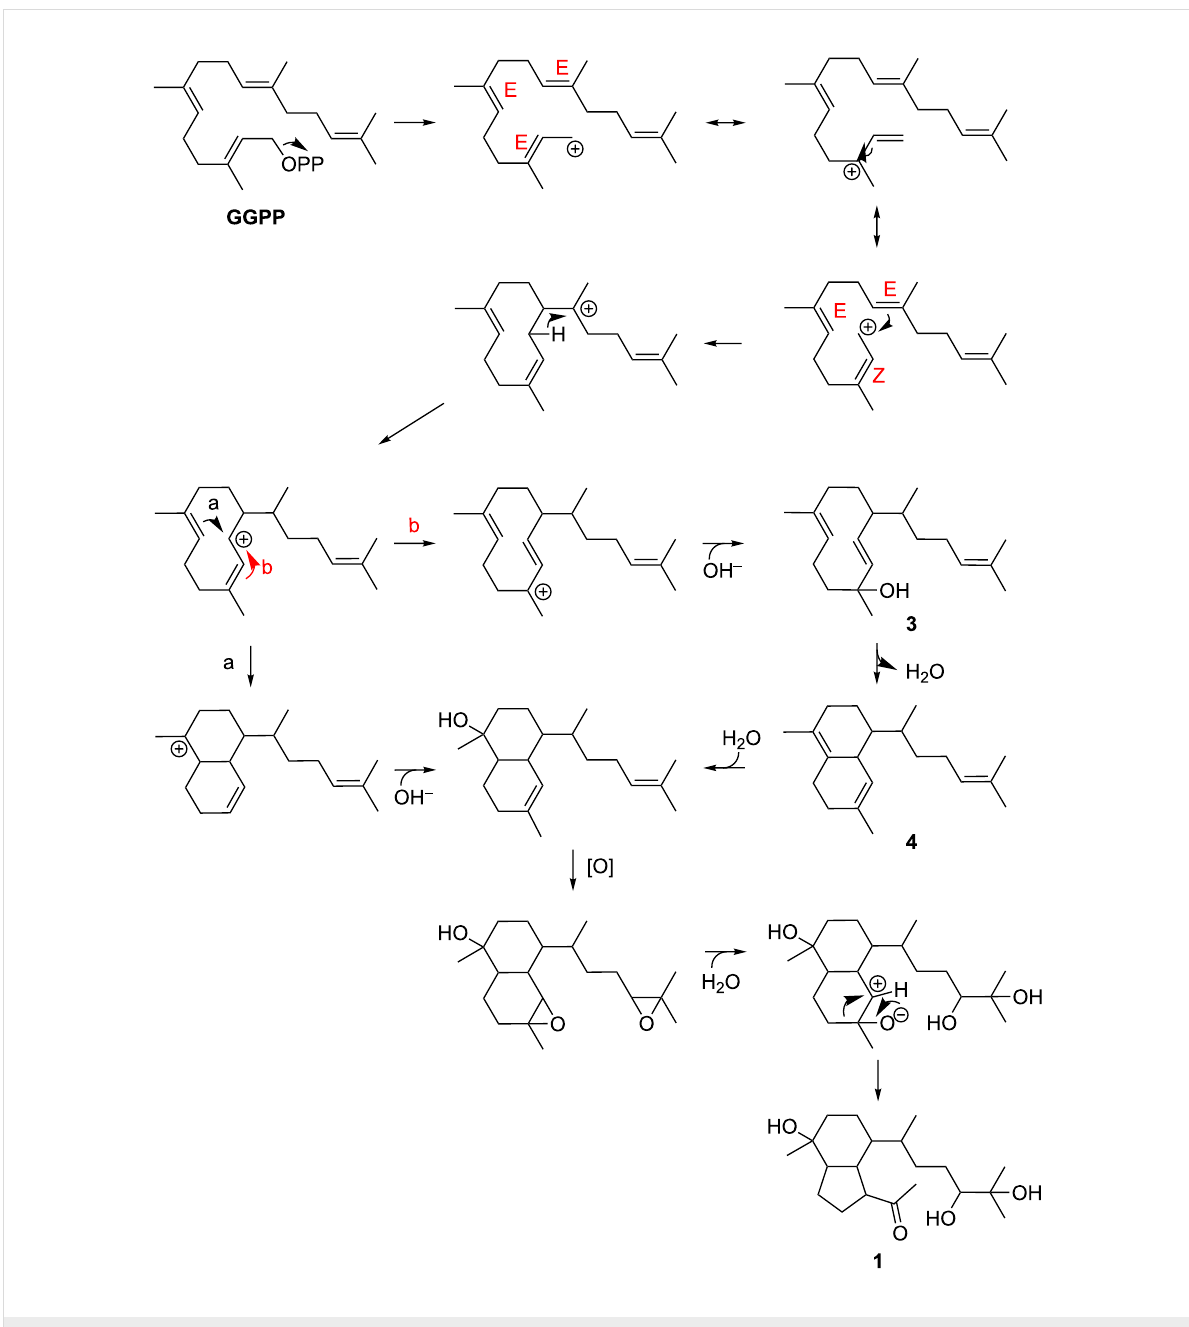
Figure 4: Proposed biosynthesis of 1 via two alternative routes (a) and (b). Route (b) involves the known diterpene obscuronatin ( 3 ).